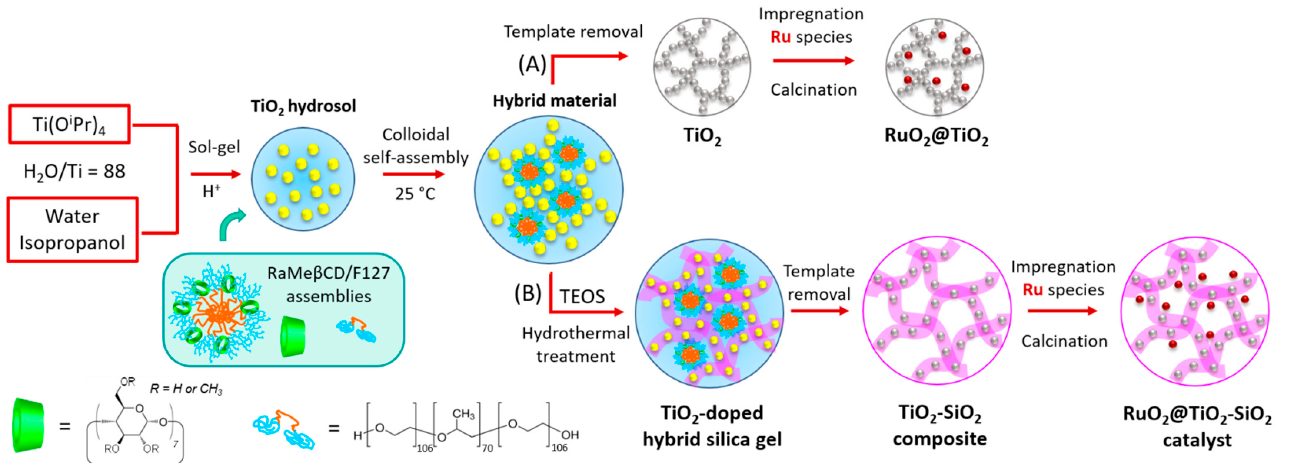
Figure 1. Schematic illustration of the colloidal approach for the preparation of the RuO 2 @TiO 2 ( A ) and RuO 2 @TiO 2 -SiO 2 ( B ) catalysts.